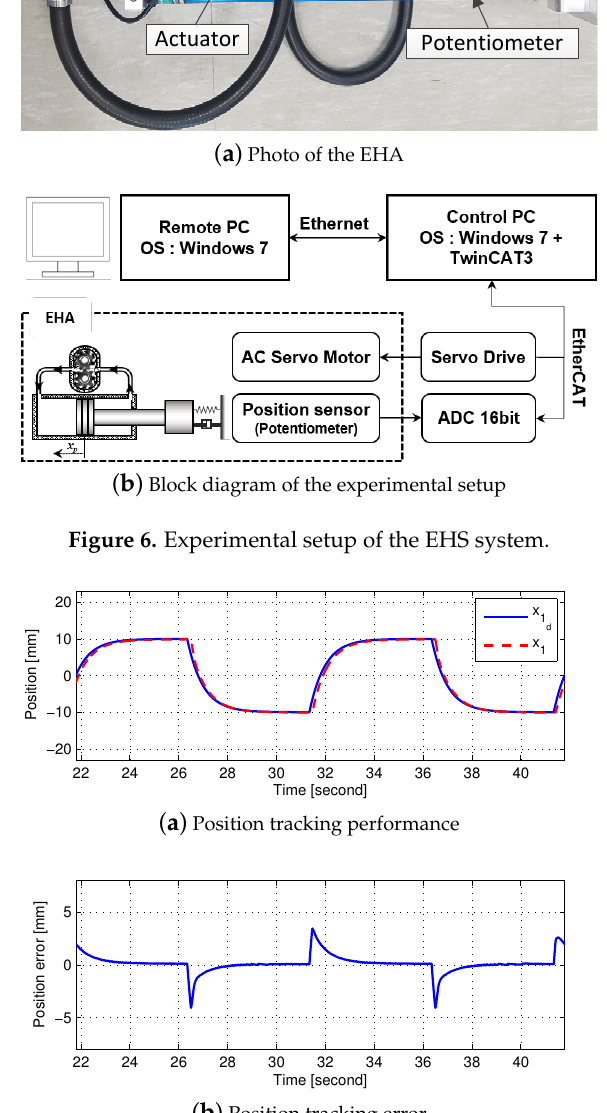
Figure 7. Position tracking performance of the PI and feedforward controller in